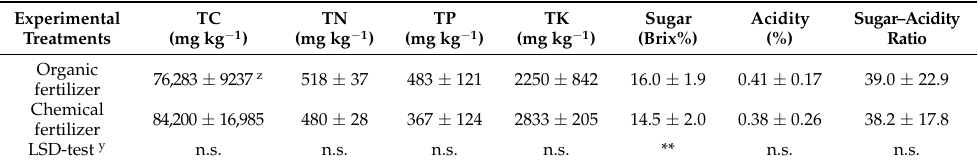
Table 2. The total carbon (TC), total nitrogen (TN), total phosphorus (TP), and total potassium (TK) of apple